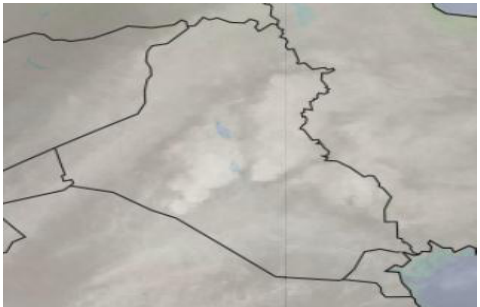
Fig. 8: Water vapor satellite image for Iraq in 24/12/2016, the dark color represent no moisture and bright color represent the region of high